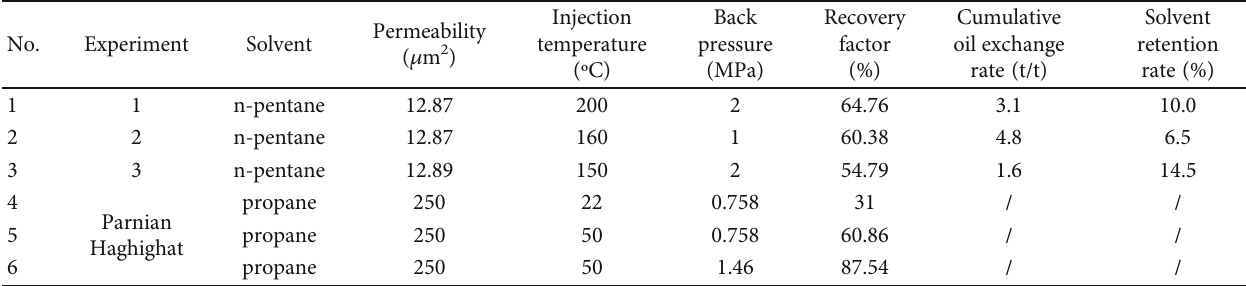
Figure 18: Change in solvent retention rate and cumulative oil exchange rate with time in Experiment 3. Table 3: Results of 3-D physical simulation